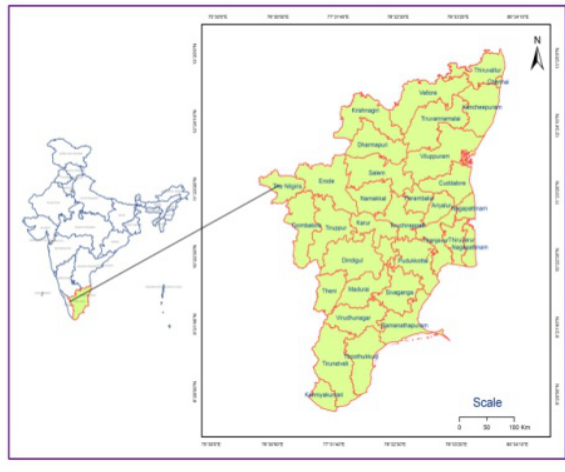
Figure 1. Location of Study area